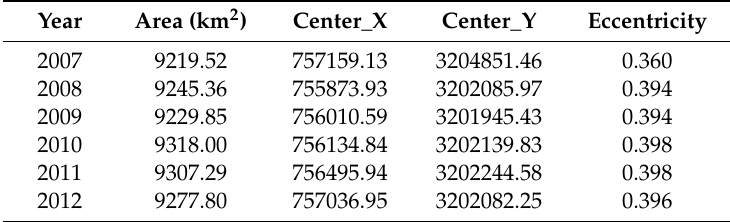
Figure 4. The SDE (standard deviation ellipse) of O. hupensis snail areas of Jianghan Plain, China, from 2007 to 2012. Table 3. Measures of yearly SDE (standard deviation